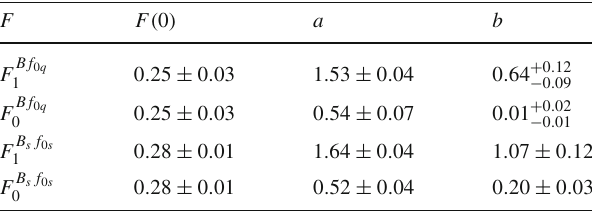
Table 4 The form factors for B → f 0 q and B s → f 0 s transitions Ref.